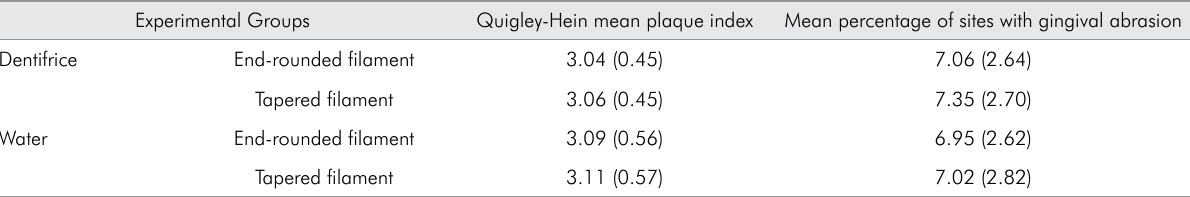
Table 2. Pre-toothbrushing data. Quigley-Hein mean plaque index (SD) and mean percentage of sites with gingival abrasion (SD). Experimental Groups